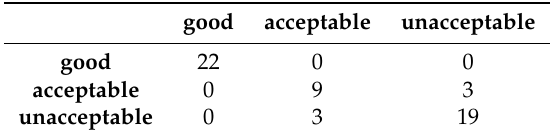
Table 8. The confusion matrix for leave-one-out validation. good